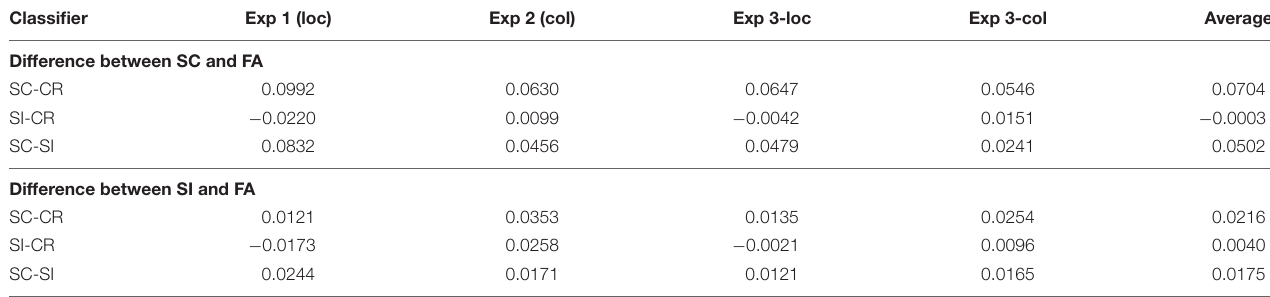
TABLE 5 | The difference between the average classifier scores for the SC and FA conditions are given in the top three rows. Classifier Exp 1 (loc)